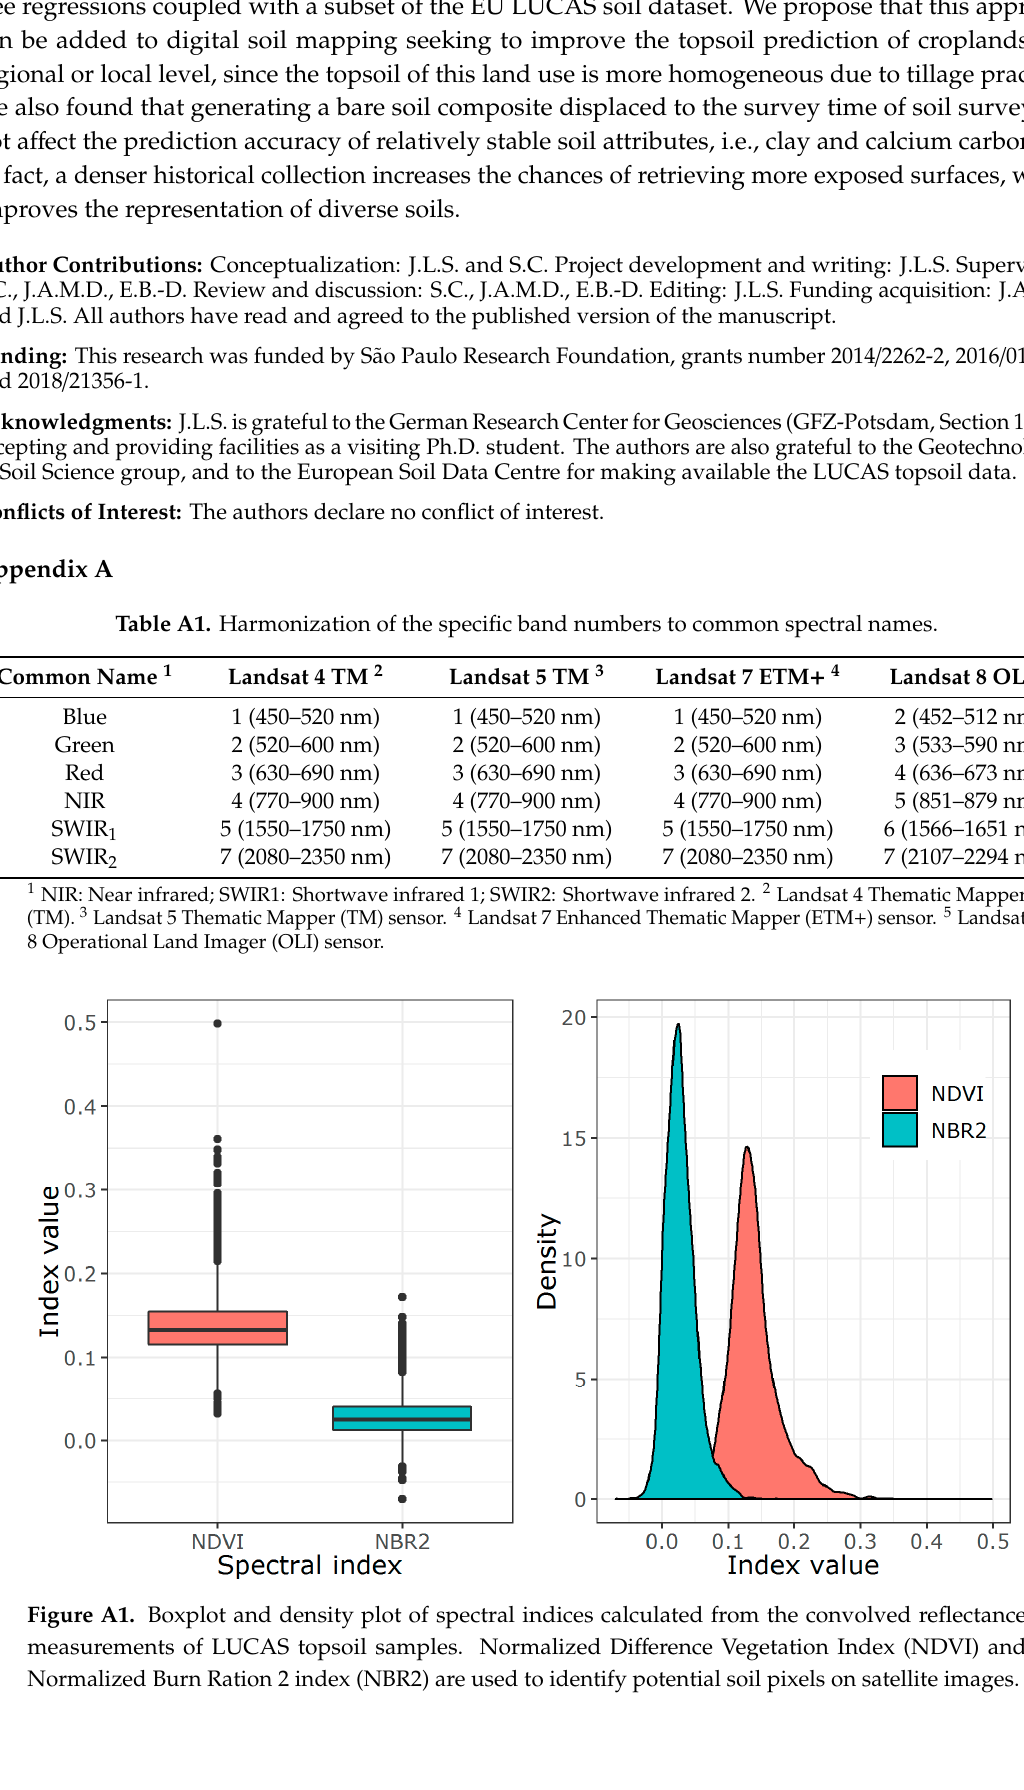
Figure A2. Location of sampling points (n = 7142) used in this study, which are a subset from the LUCAS dataset of 2009 and were split in training (80%) and testing (20%) samples.